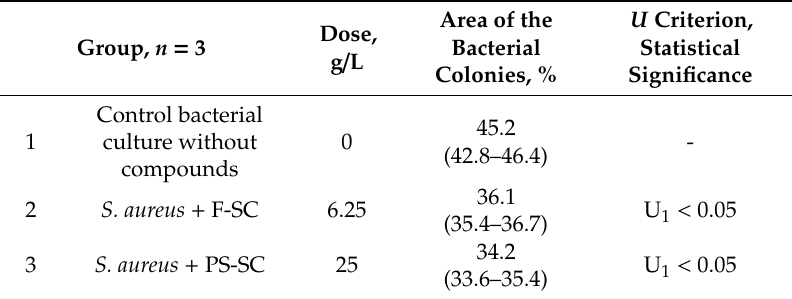
Table 3. Minimal bacteriostatic doses of tested compounds suppressing growth of S. aureus strain 209P for 24 h in an agar medium after spending 24 h in a preliminary liquid culture, Me (Q1–Q3).